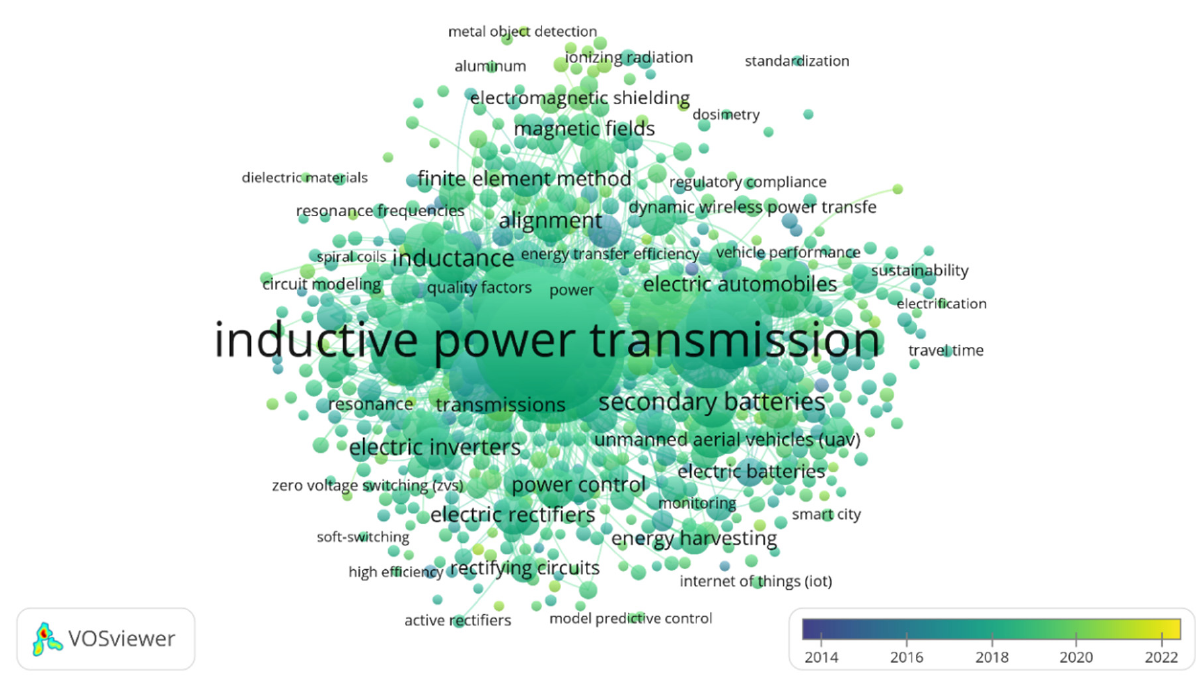
Figure 4. Network of co-occurring keywords related to WPT applications in EVs based on timelines.